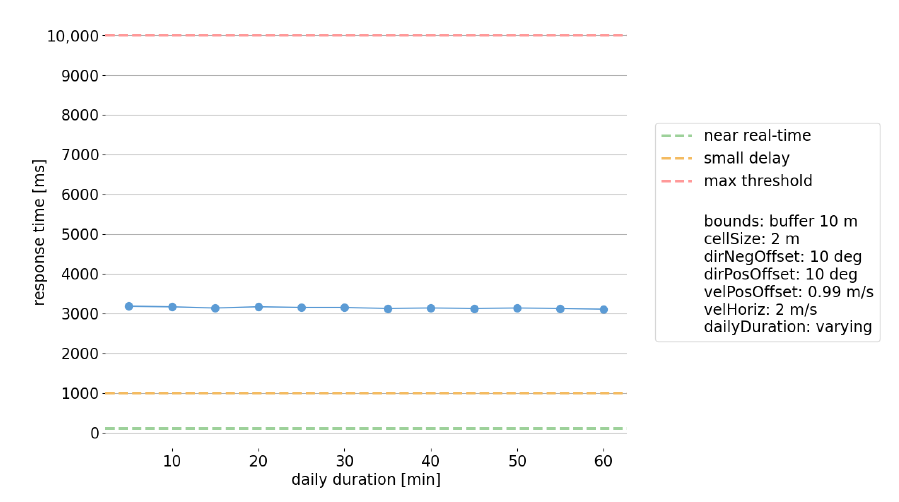
Figure 18. The response times when the wind daily duration varies.